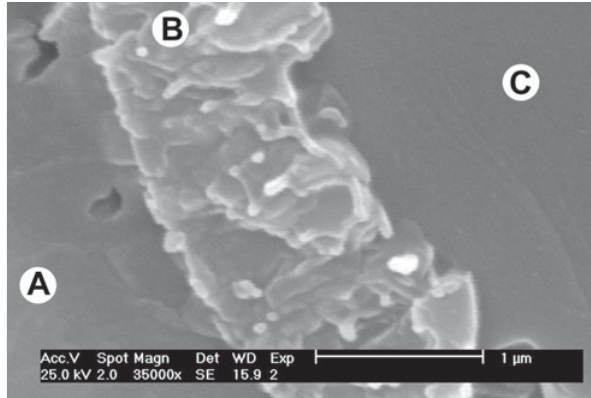
Figure 6. Detail of reaction taken from figure 5 showing aluminium matrix (A), reacted co-continuous region (B) and silica untransformed (C).Some necking of metal phase inside the B re- gion can be see.